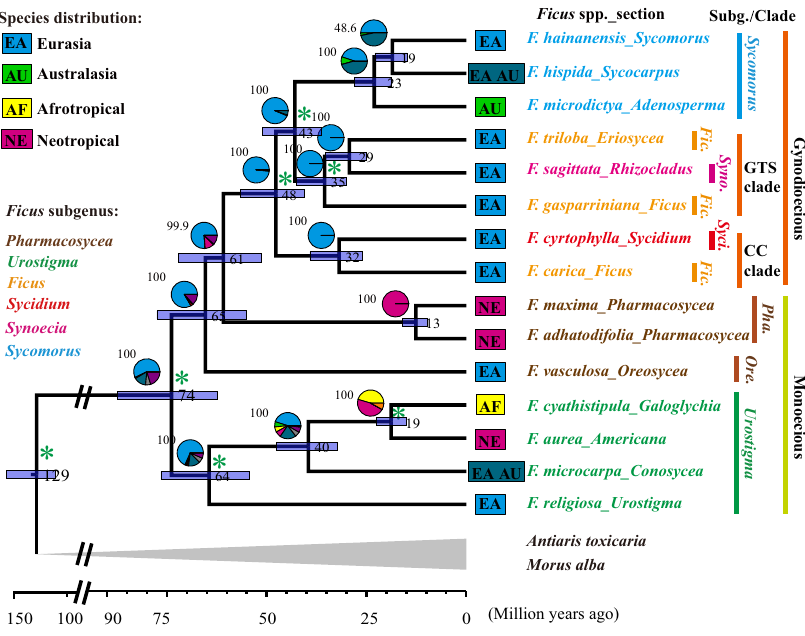
Fig. 1 Ficus Astral species tree (based exclusively on nuclear data) with inferred divergence times and ancestral geographic ranges of Ficus . The Astral Ficus species tree was inferred based on non-overlapping 100-kb genomic windows, with almost all nodes being highly supported with bootstrap values >99, excepting one (48.6). The bootstrap values are indicated above the pie chart at each node. Values and bars on the nodes indicate the mean and 95% credibility intervals of node age. The pie charts indicate the relative probability of possible geographic ranges estimated. Current distribution range of related section (tip symbols) and the subgenus information (tip name color) of sampled species are also shown. Green asterisks indicate calibrated nodes used for inferring divergence times. Ranges that are combinations of these four distributions are indicated by colors formed by mixing of the four component distribution colors. Both species distribution and taxonomic classi fi cation follow Cruaud et al. 20 . Ficus is inferred to have originated in Eurasia and all main clades have more than 10 million years history of coexistence in Eurasia, before dispersal to other areas. This ancestral sympatry could have permitted ancient hybridization among them. Refer to Supplementary Figs. 1 – 3, Supplementary Table 3, and Appendices 1, 3, and 4 for